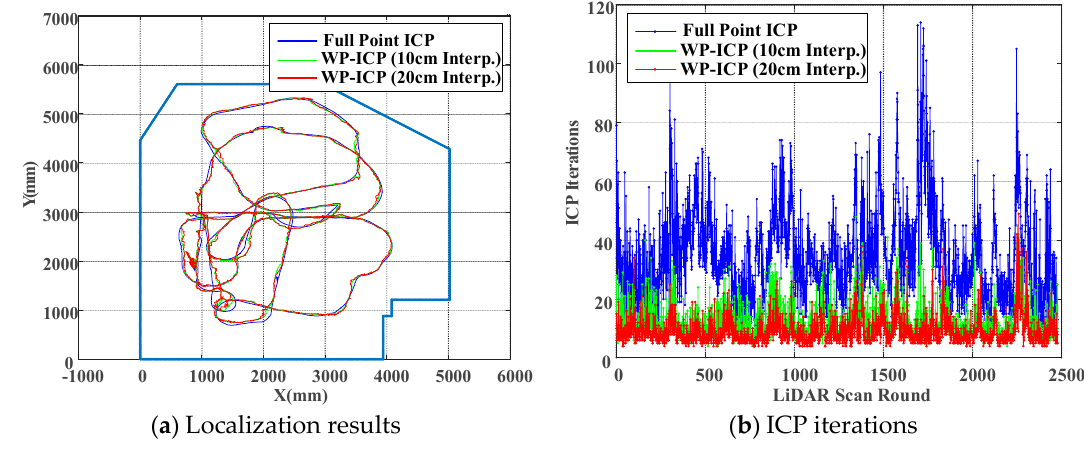
Figure 23. Localization result using the WP-ICP with 20 cm interpolation.